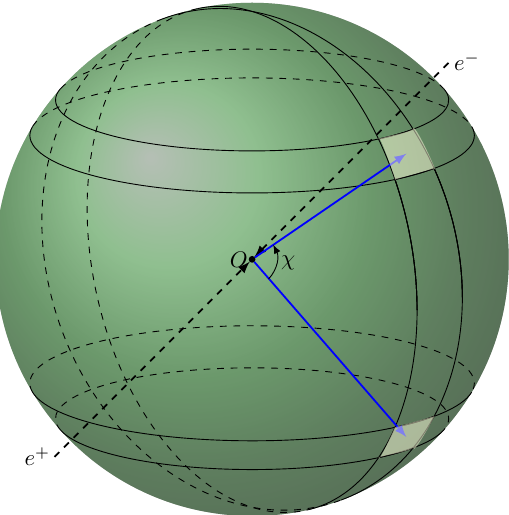
(cid:0) annihilation, which is de(cid:12)ned as the